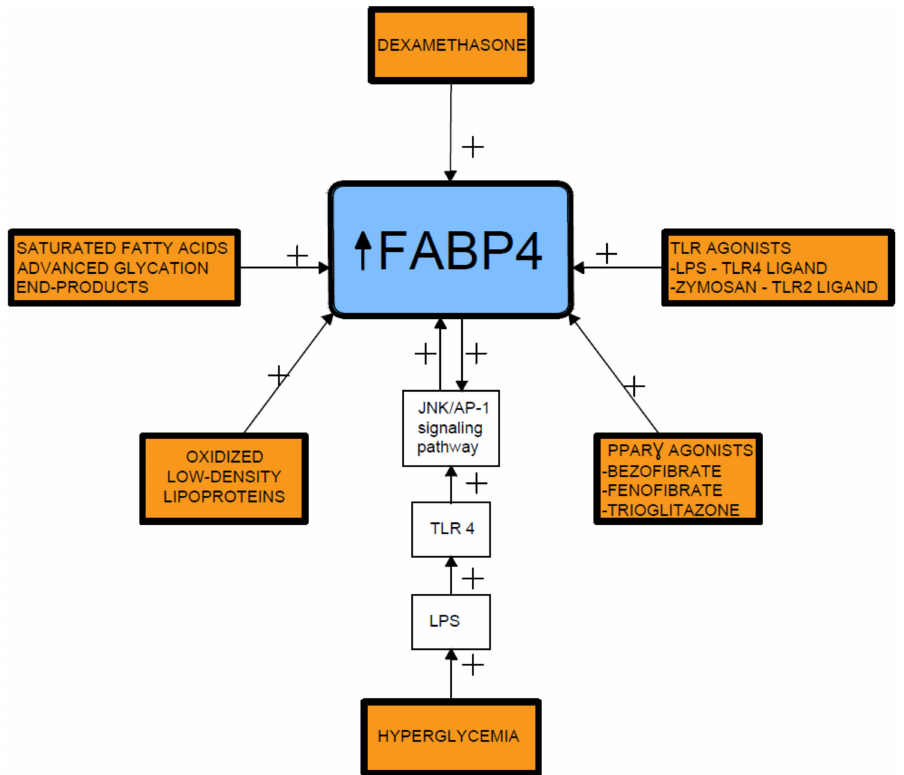
Figure 2. Fatty acid-binding protein 4 inducing factors. TLR- toll-like receptor; LPS- lipopolysaccharide; FABP4-fatty acid-binding protein